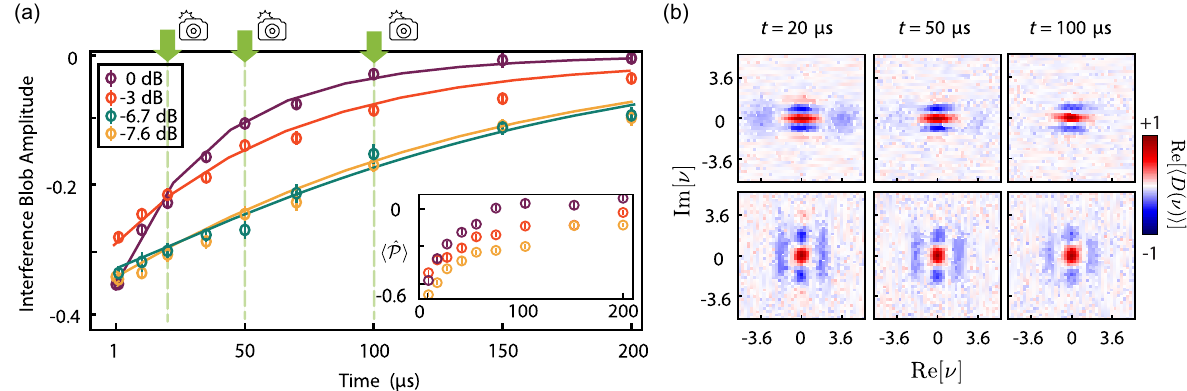
FIG. 4. Time dynamics of interference features in the presence of intrinsic losses in the hardware. (a) The measured contrast (marker) of the blobs in the characteristic functions of odd cat states with 0, − 3 , − 6 . 7 , and − 7 . 6 dB of compression along Re ½ ν (cid:3) . The decay is significantly slower for the compressed cat states, which demonstrates that compression and the resulting compactness in phase space protects the quantum interference features in cat states. The measured contrast agrees closely with the master equation simulation (solid lines) with cavity photon loss as the dominant error. Analytical expression provided in Appendix F models the short-time dynamics of ˆ P i our data accurately. Inset: the equivalent decay of the photon number parity h extracted from the Wigner functions of the same set of states; see Appendix E. The preservation of the odd parity indicates that compressed cat states are more resilient toward photon loss, in agreement with the metric obtained using characteristic functions. All associated uncertainties are extracted by standard bootstrapping techniques. (b) Selected characteristic functions at different decay times, showing the effective preservation of the blobs due to